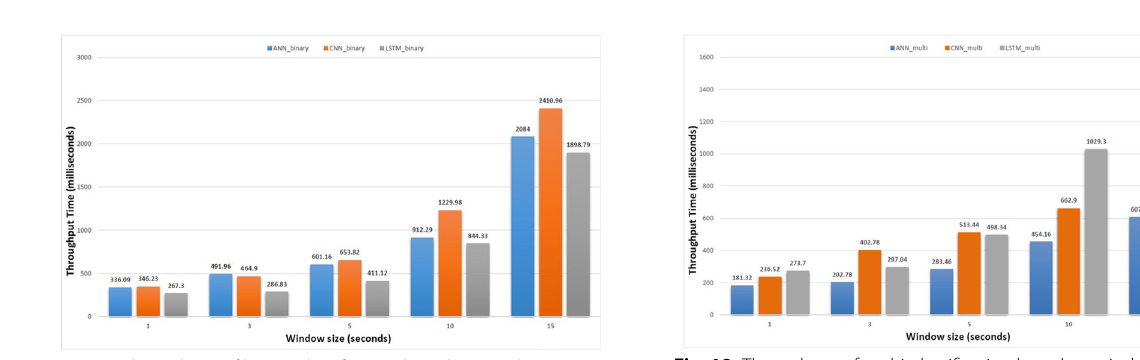
Fig. 17 Throughput of binary classification based on window size Fig. 18 Throughput of multi-classification based on window